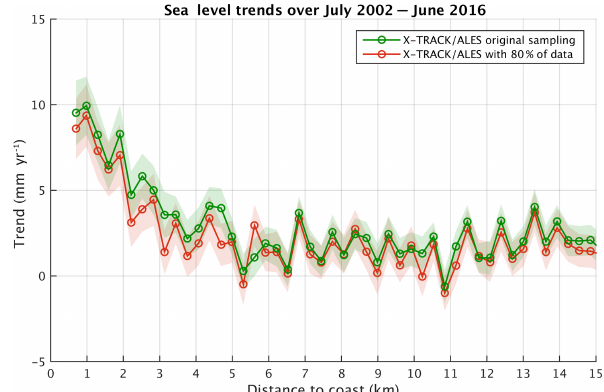
Figure 6. Percentage of missing points for the original data set. ing only the 80 % of data common to all along-track positions at a given time.